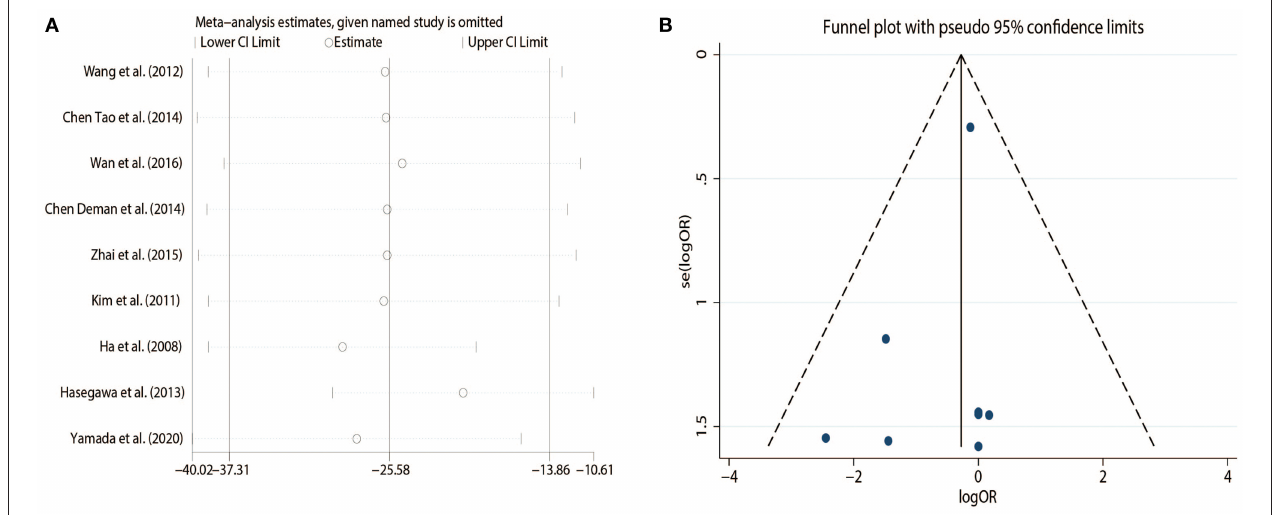
FIGURE 3 | (A) Sensitivity analysis on the operation time, (B) The funnel plot on the